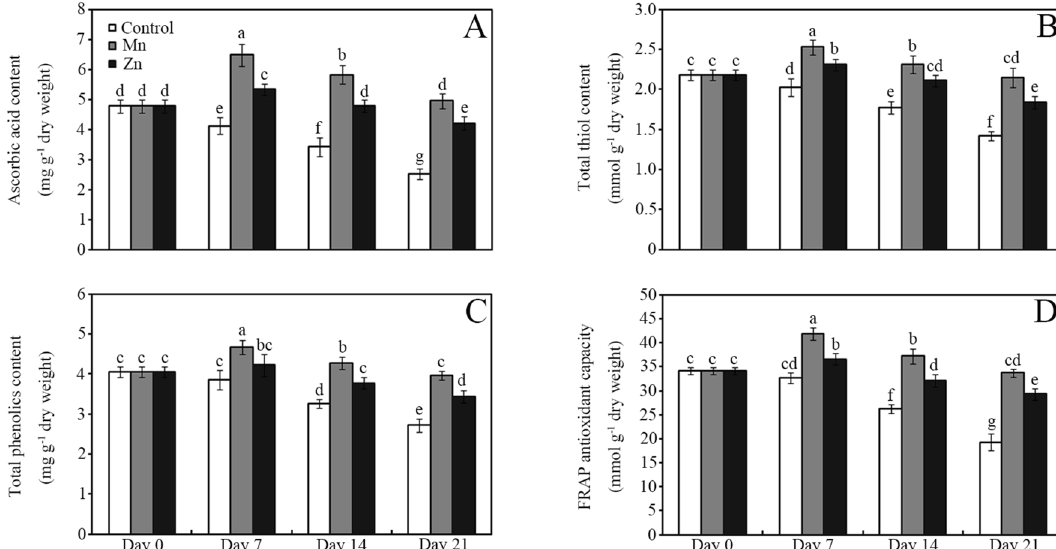
Figure 2. Effects of 10 mM MnCl 2 and ZnCl 2 on ascorbic acid level ( A ), thiol content ( B ), total phenolic content ( C ) and FRAP antioxidant capacity ( D ) of soya bean sprouts after storage for 0, 7, 14 and 21 days. Bars represent the standard deviation of the mean ( n = 3); means associated with the same letter are not significantly different ( P <